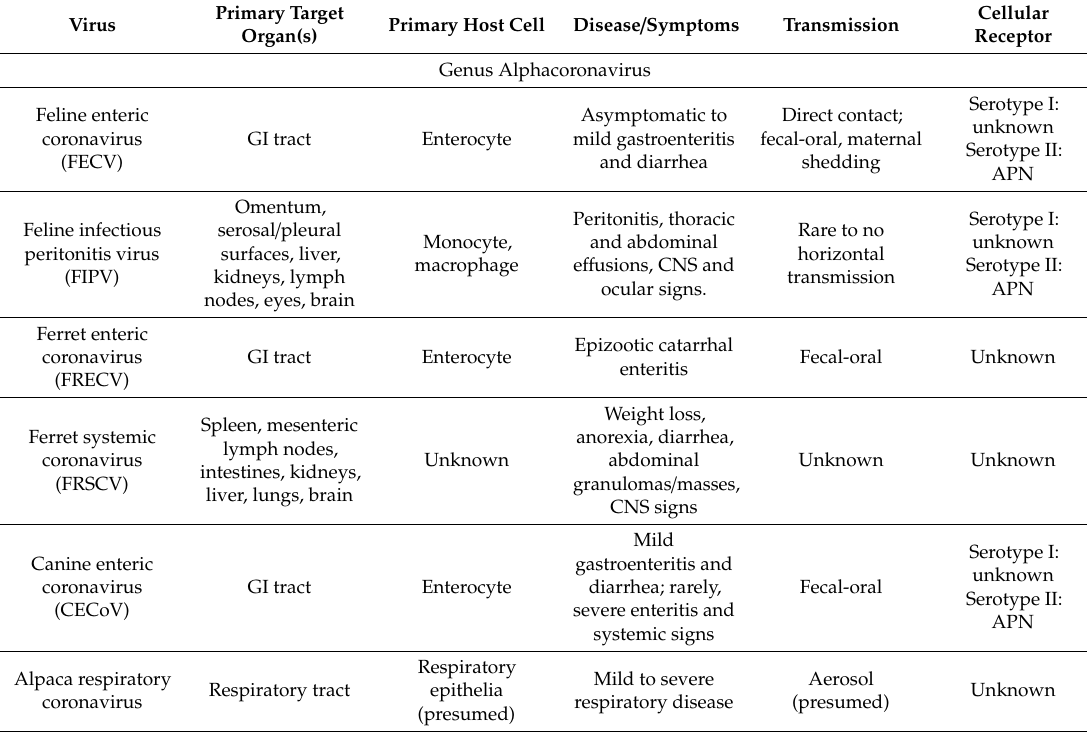
Table 1. Clinical and pathologic features of major coronavirus infections of companion